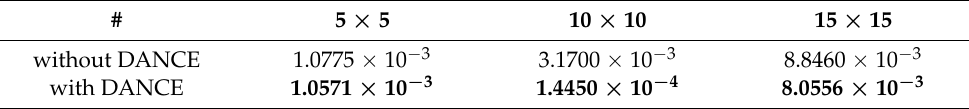
Table 2. The average Euclidean distances with and without DANCE on the Indian Pines